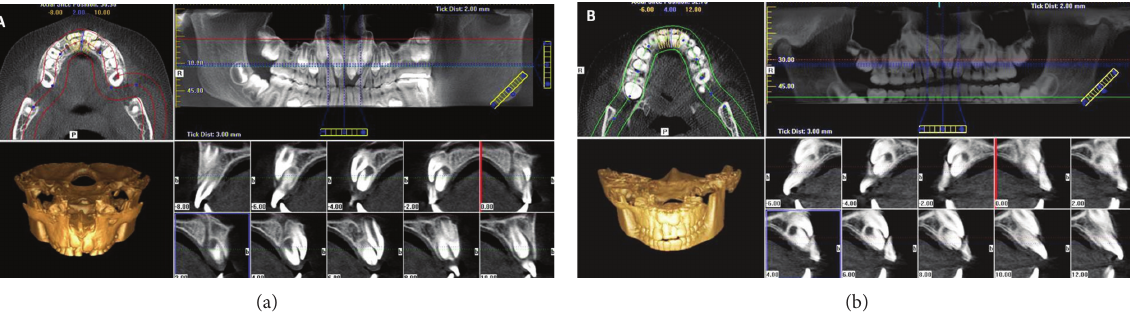
Figure 4: The cross-section oblique images showing impacted permanent maxillary central incisors and the relationship with two mesiodens in both